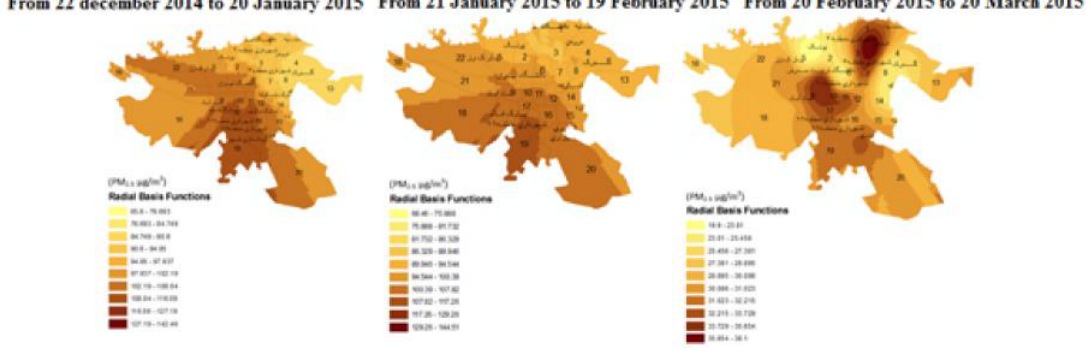
Fig. 5: Model results of fine particulate air pollution contours map using RBF-based approach for PM